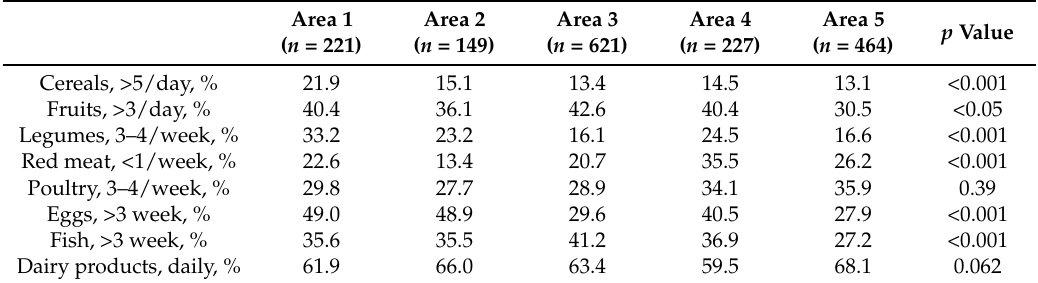
Table 4. Regional difference of the consumption of key components of Mediterranean